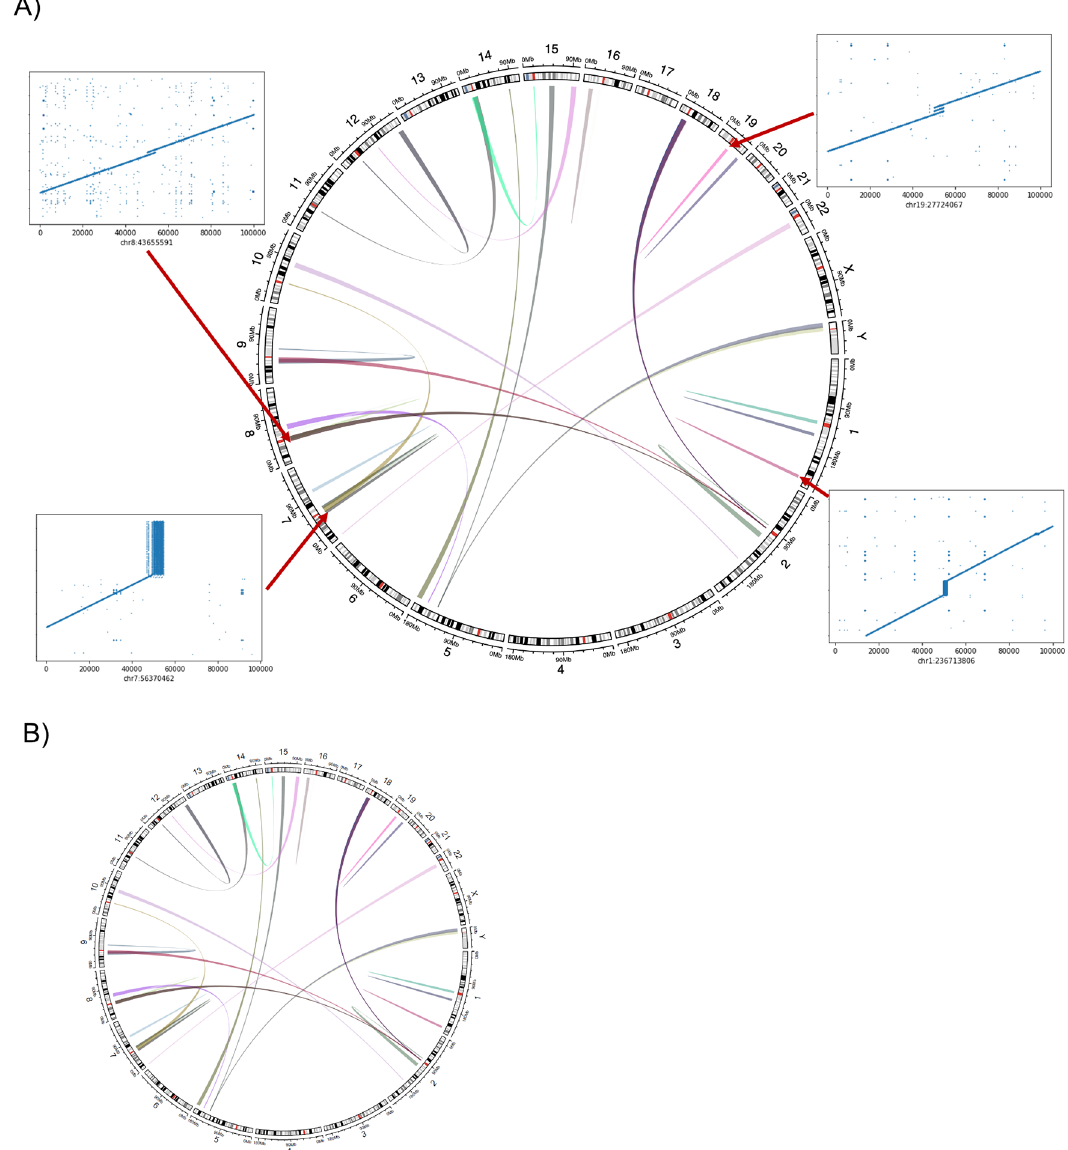
Figure 11. Relationship between the CNV calls and identified SVs across the CHM13 genome. CNV2SV results using CHM13 in comparison to GRCh38. (A) The diagram connects the genomic location of individual CNV calls on GRCh38 (broad ends) to the location of their linked SV identified in the GRCh38-CHM13 genome-genome alignment (thin ends). The diagram reveals anumber of underlying putative translocation events identified for the called CNVs. Adjacent CNV-SV links (putative tandem duplications) are shown as streaks at the respective genomic position. For four select CNV-SV links, the genome-genome alignment for the underlying SV is further shown as a dot plot on the outside of the diagram. Only the best matching SV link (thin end) identified for each CNV call (broad end), as determined by sequence alignment score between both events, is shown here. (B) Similar to A, but displaying all potential CNV-SV links that meet the default alignment identity threshold of 0.8. CNVs with multiple matching duplication SV events identified in the genome-genome alignment can be explained by copy numbers greater than two occuring in distant locations, and alternatively may suggest the involvement of complex genomic rearrange- ments including transposable first called in the normal sample and labeled as “ germline ” , and then the resulting SVs called using the tumor sample (separately or jointly with against the normal) are labeled as “ somatic ” . While such an approach is common for short-read SV callers, this frequently leads to mislabeled results, often for the simple reason that the normal sample is sequenced at a much lower coverage than the tumor sample.